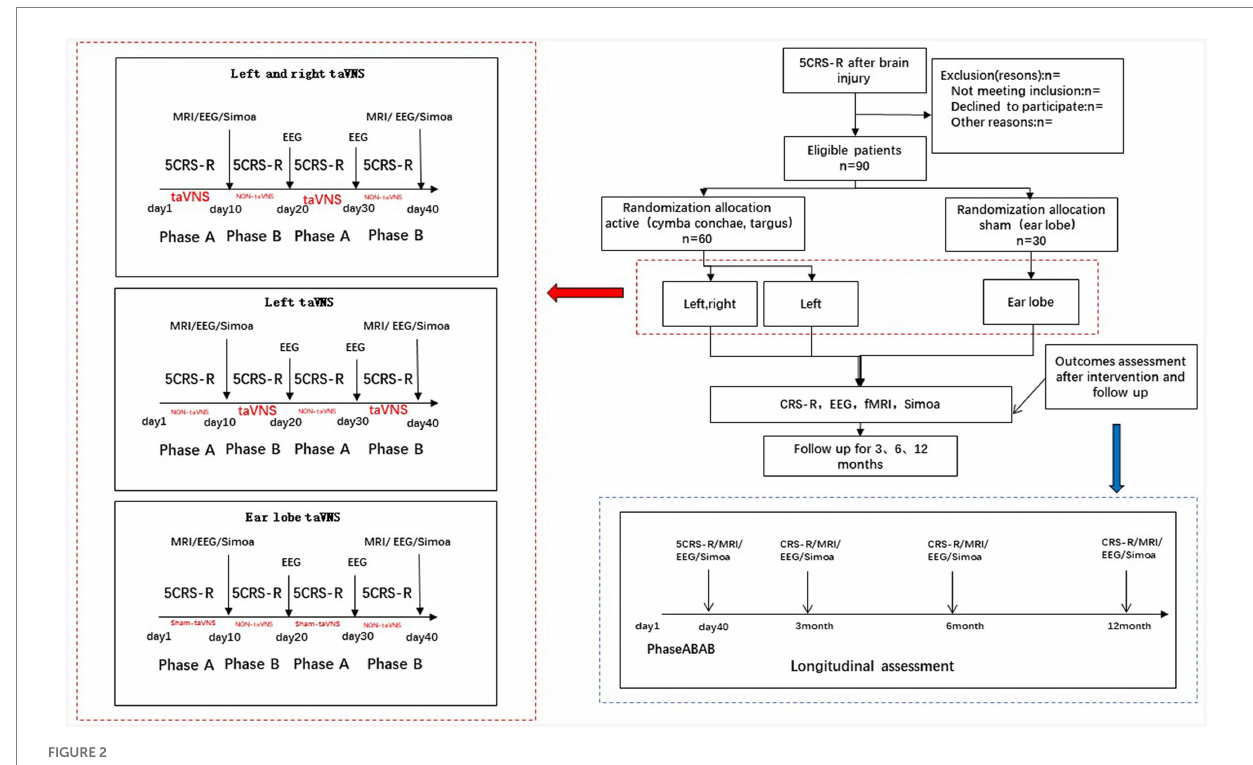
FIGURE 2 The taVNS stimulation